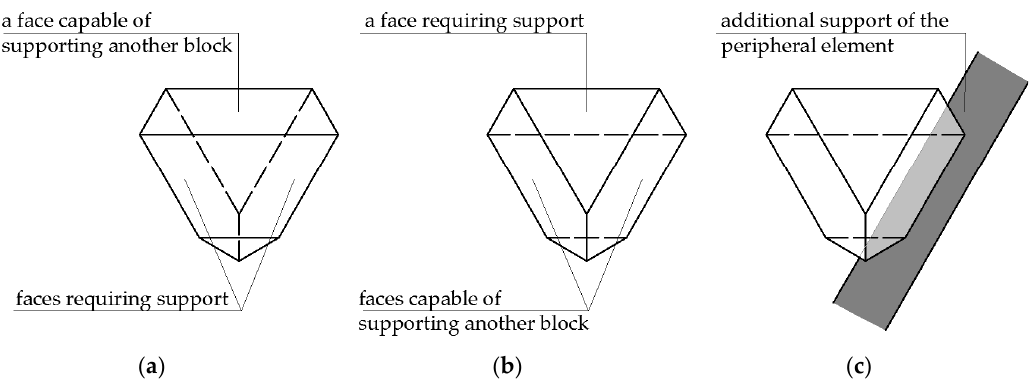
Figure 6. Stabilization of a triangular component depending on its orientation in space and location in the slab: ( a ) stable component; ( b ) unstable component; and ( c ) stabilization with additional support.